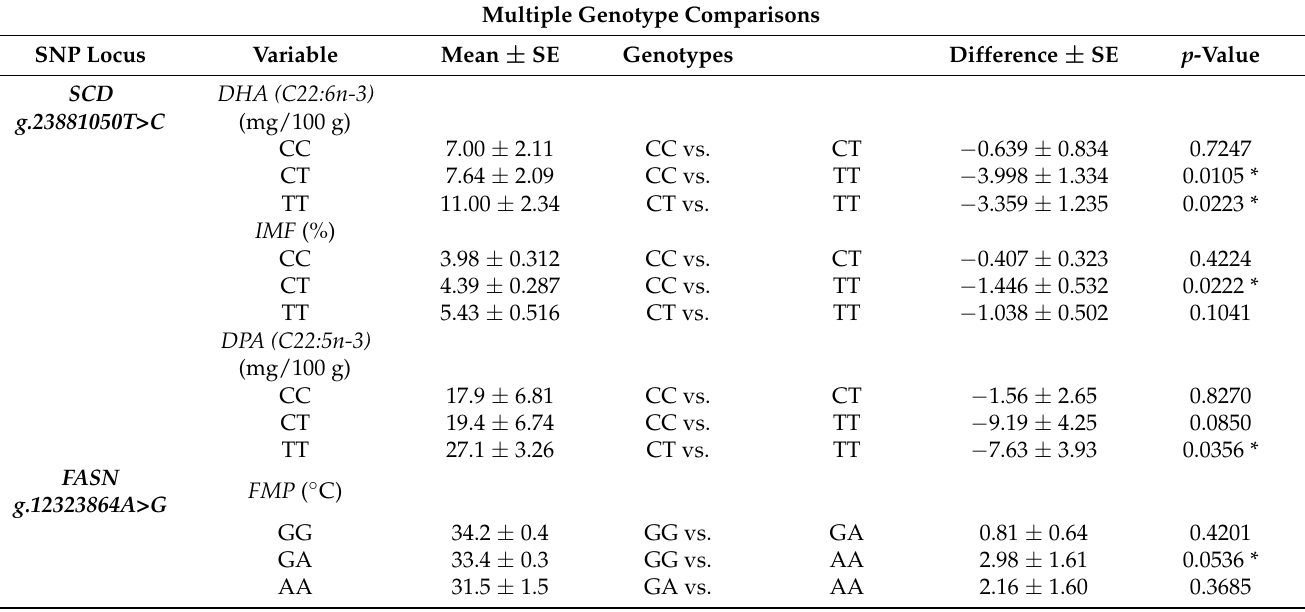
Table 6. Tukey-adjusted multiple comparisons between SNP mutations and FMP, IMF, and fatty acids in TAW lambs #